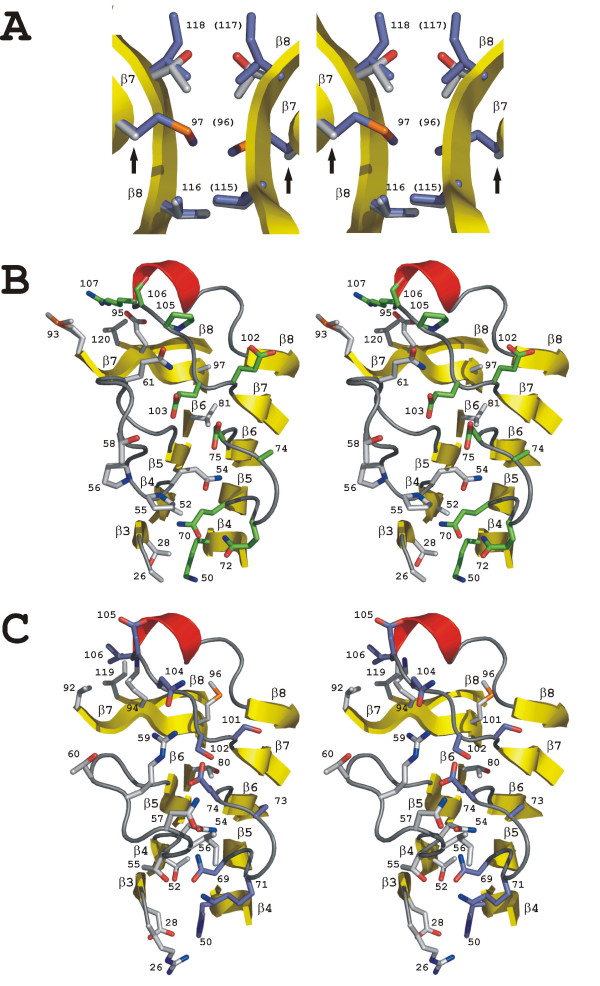
Stereo images of the 1–3 and 1–4 subunit interfaces of BBP-A and AVD. (a) The 1–3 subunit interface of the AVD [PDB: 1VYO] [68] structure superimposed with the corresponding interface of the BBP-A – BSO structure. The carbon atoms of amino acids from BBP-A and AVD are coloured light grey and blue, respectively. Amino acids and β-sheets are numbered. Two occurrences of Ala97 in the BBP-A structure are indicated by arrows. (b, c) A simplified view of the 1–4 interface of the BBP-A – BSO (b) and AVD [PDB: 2AVI] [9] (c) structure after superimposition. The atoms of the non-conserved side chains of amino acids within 4 Å of subunit 1 of either the BBP-A or AVD structure are shown. For clarity, Met96 and Thr110 of BBP-A as well as the equivalent residues of AVD (Thr95 and Asp109) are not shown, and only one half of the symmetrical 1–4 interface is shown. The carbon atoms of residues from subunit 1 and 4 are respectively coloured light grey and green in BBP-A, and grey and blue in AVD. Amino acids and β-sheets are numbered.